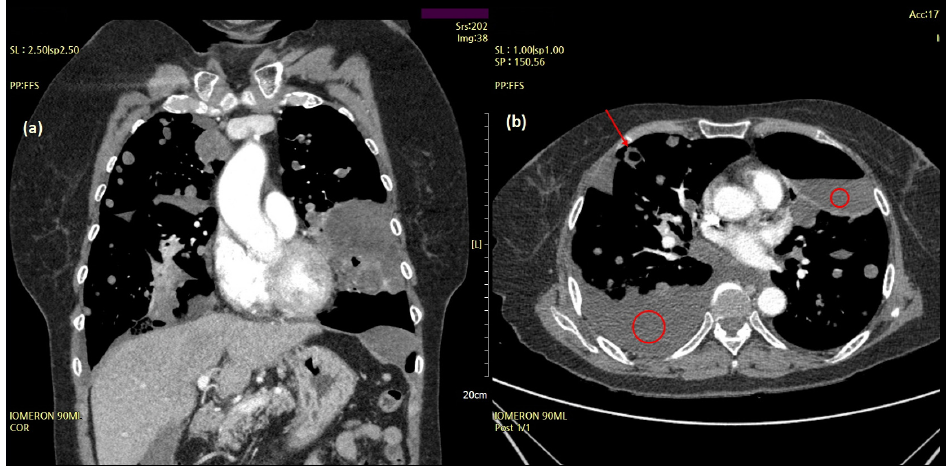
Figure 2. Chest computed tomography (CT) features of the aggravating lesions. Cystic masses (arrow) and large and multiple hydropneumothoraces with massive pleural effusion (red circles) on chest CT (June 2019). ( a ) Coronal and ( b ) axial views.